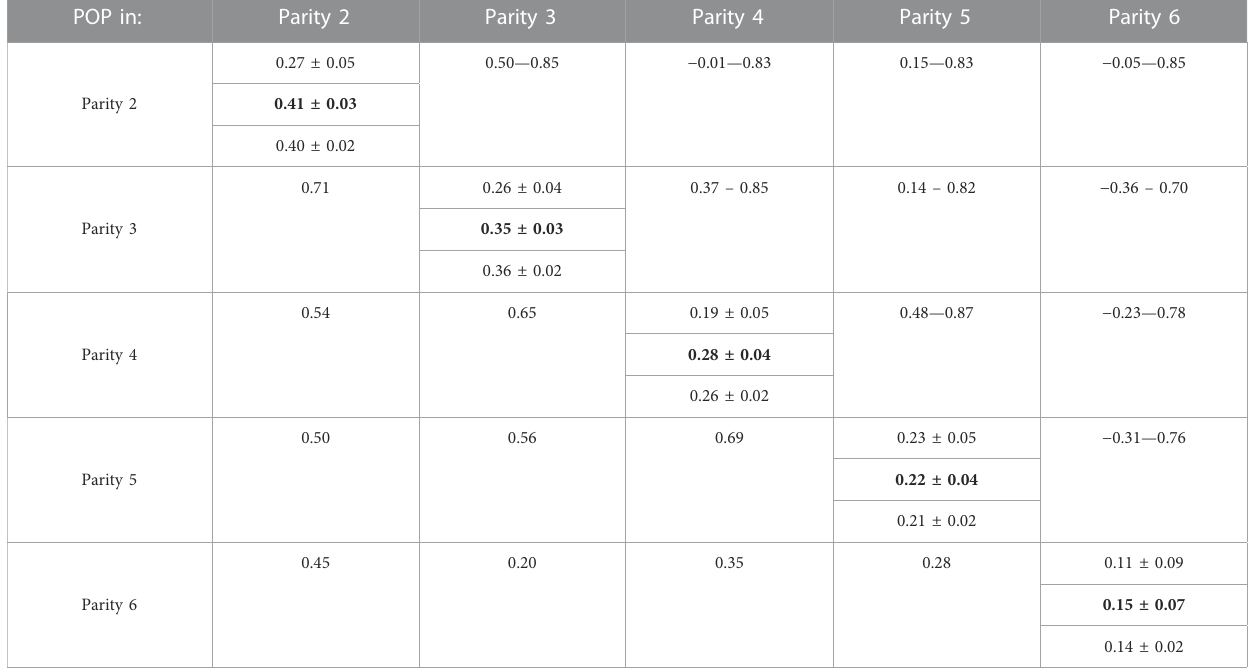
TABLE1Estimatesofgeneticparametersofpelvicorganprolapse(POP).Estimatesofheritability(±SE)basedonlogitmodelsareonthediagonal(estimatesusing pedigree on fi rst line; estimates using genomic relationships in bold on second line; estimates using Bayes-B analysis on third line). Off-diagonals are posterior means of genetic correlations between parities (below diagonal) and Lower/upper bounds for 95% Highest Posterior Density (HPD) intervals of genetic correlations (above diagonal) based on bivariate linear models using genomic relationships. POP